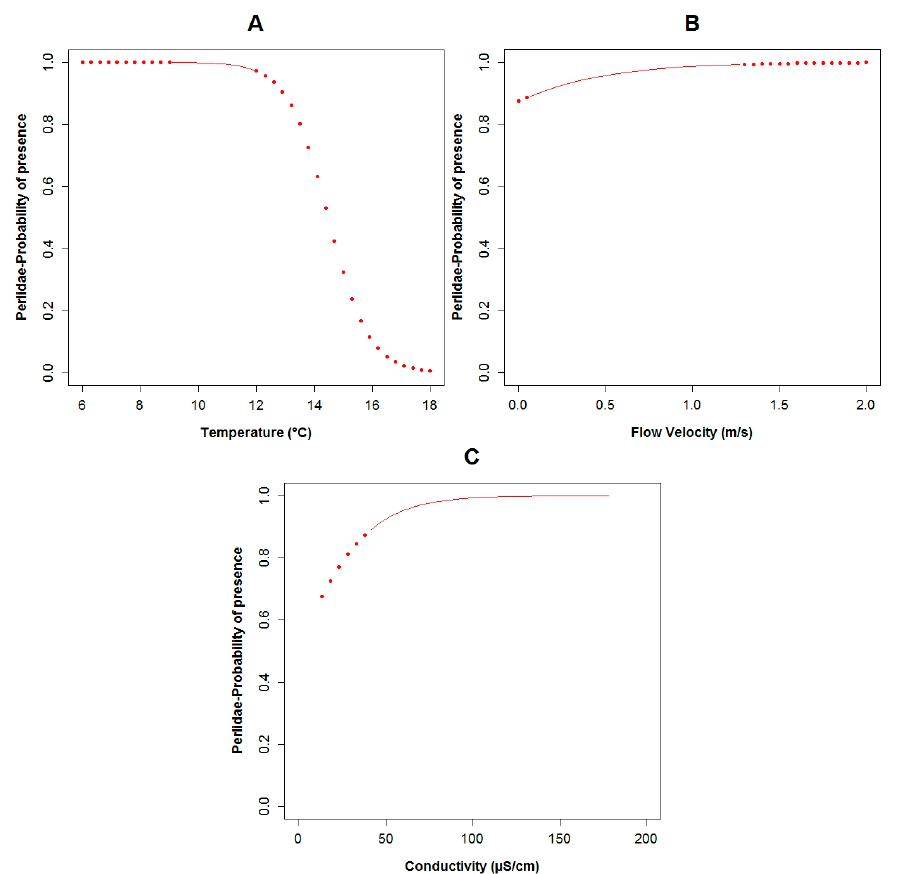
Figure A11. The probability of Perlidae being present in relation to: ( A ) temperature; ( B ) flow velocity; ( C ) conductivity. (The red points in the curves indicate extrapolation outside the observed physicochemical variables range).